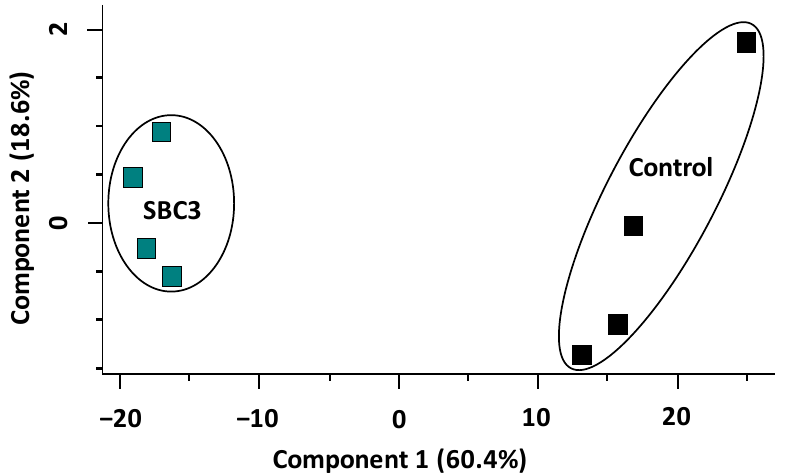
Figure 2. Principal component analysis (PCA) of SBC3-treated P. aeruginosa versus untreated control samples.